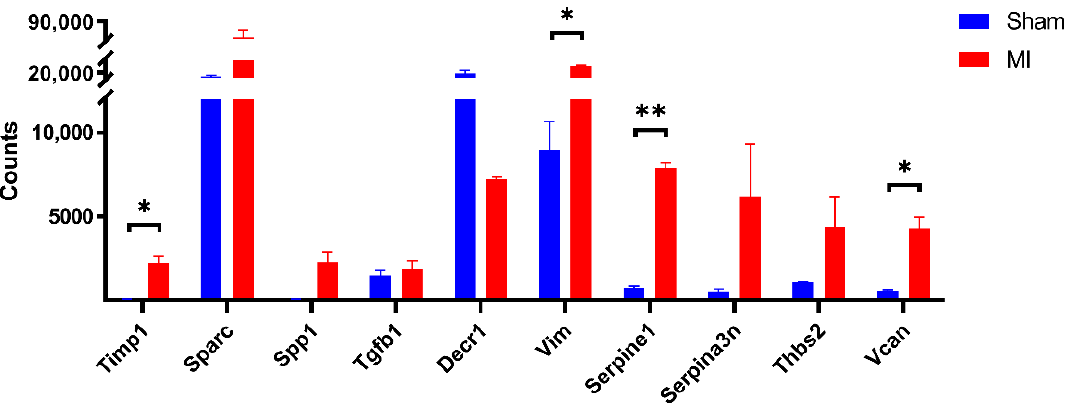
Figure 7. Hub gene expression in cardiomyocytes in GSE119857. MI indicates infarction surgery group, Sham indicates sham surgery group. Error lines indicate SEM. * p < 0.05, ** p < 0.01, Mann- Whitney U test.